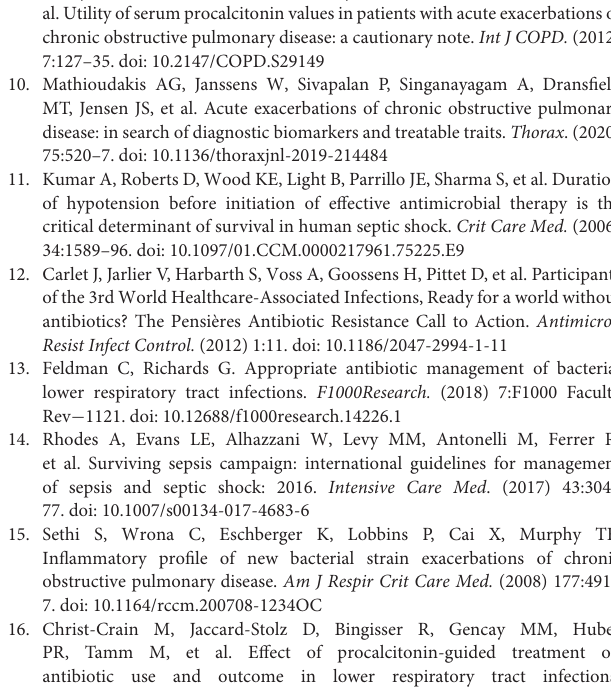
Supplementary Figure 1 | Forest plot of white blood cell count. WBC was measured in AECOPD cases with bacteria positive and bacteria negative microbiological cultures. WBC was reported in (1000/ml) in each study. WMD = 1.07, 95% CI: 0.40961.74, (p = 0.002). AECOPD, acute exacerbation of chronic obstructive pulmonary disease; WBC, white blood cell count; SD, standard deviation; WMD, weighted mean difference; CI, confidence interval. Supplementary Figure 2 | Methodological Quality Assessment of DTA-NMA. The graph shows the summary of methodological quality assessment of studies according to Quality Assessment of Diagnostic Accuracy Studies-2 (QUADAS-2) tool concerning risk of bias and applicability in review authors’ judgments about each domain (patient selection, index tests, reference standard and flow and timing) for each included study. The second column shows review authors’ judgments about each domain, presented as percentages across included studies. Green color represents low risk, yellow represents unclear risk, and red represents high risk of bias. CRP, C-reactive protein; IL-1b, interleukin one beta; IL-8, interleukin eight; MPO, myeloperoxidase; NE, neutrophil elastase; N/L,